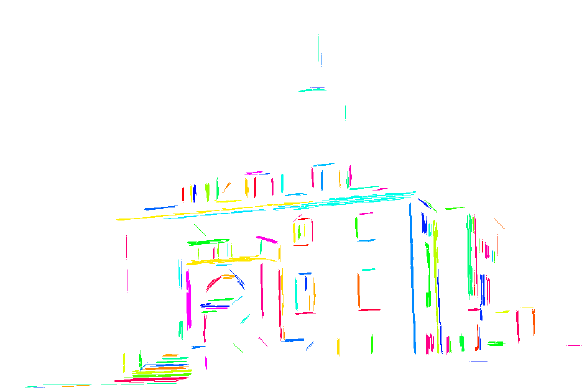
Figure 7: Segmentation result in relation to figure 2, each seg- ment is drawn in a different